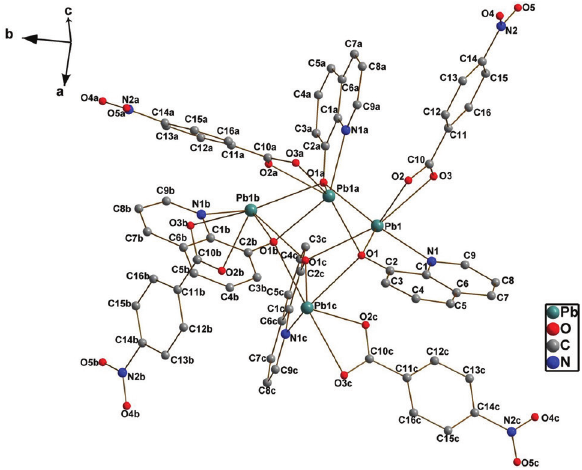
Figure 1: A view of the molecular structure of complex. Hydrogen atoms are omitted for clarity.